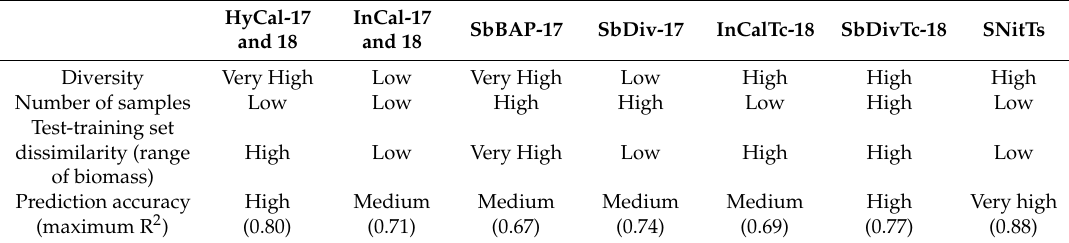
Table 3. Summary of the prediction results of the experimental trials.